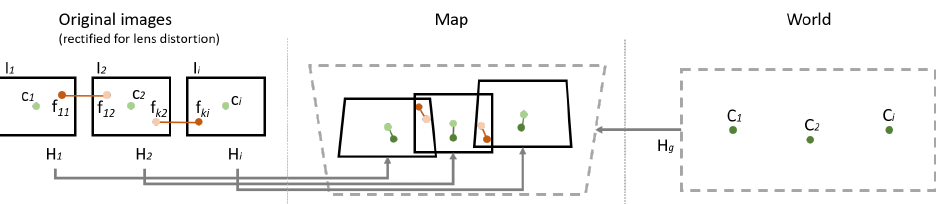
Figure 5. Illustration of objective function